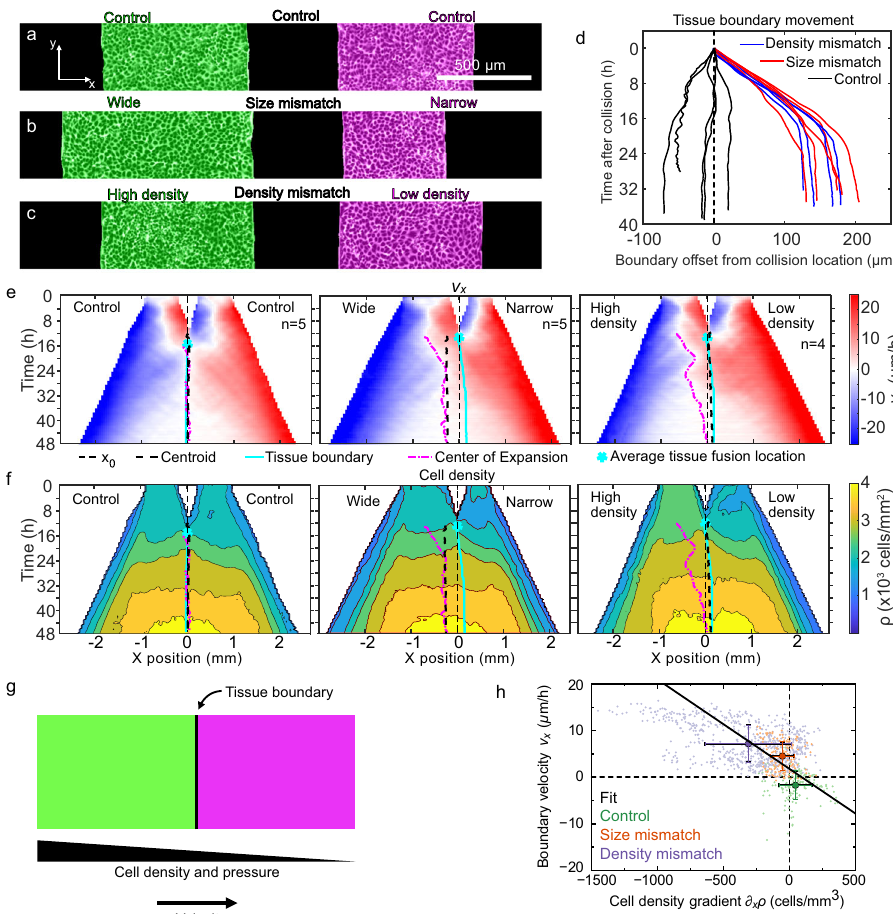
Fig. 2 Asymmetric tissue collisions produce boundary motion. a – c Initial condition of collisions between control ( a ), size mismatch ( b ), and density mismatch ( c ) rectangle tissue pairs. Micrographs are representative of n = 5 (control), n = 5 (size mismatch), and n = 4 (density mismatch) independent experiments with similar results. d Tissue boundary displacement in both mismatch and control collisions. e , f Kymographs of tissue velocity v x ( e ) and cell density ( f ) along the collision direction for control (left, n = 5), size mismatch (center, n = 5), and density mismatch (right, n = 4) collisions. The superimposed curves indicate initial midline location x 0 (thin black dashed line), the geometric tissue centroid (thick black dashed line), the tissue boundary (cyan line), and the center of expansion (pink dash-dotted line), as de fi ned in the text and Methods. The cyan star marks the average tissue fusion location, which occurs at the initial point of the tissue boundary line. Panels d – f are from the same data set. g Our model proposes that the tissue boundary moves driven by pressure gradients between tissues of different cell densities. h Consistent with our model, the velocity and the cell density gradient at the tissue boundary are negatively correlated (correlation coef fi cient r = − 0.47). Small points represent individual data, big points correspond to the averages for each of our three assays, and the black line is a linear fi t through the averages. This plot includes data from experiments with initial density mismatches higher than in panels d – f . The range of applicability of our model extends to all of these density mismatches (additional n = 16, Supplementary Figs. 4 and 5). Error bars are standard deviation. See Supplementary Videos 5 and